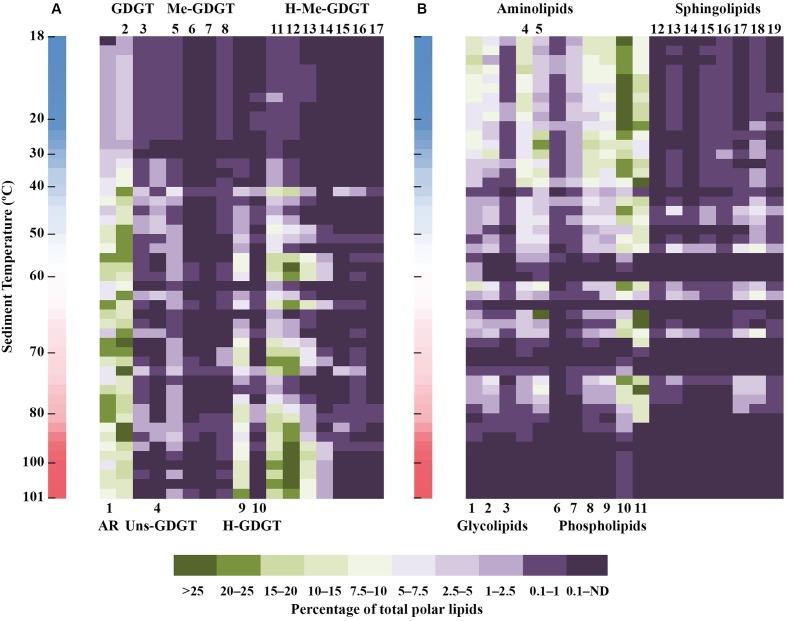
Heat map distribution of archaeal (A) and non-archaeal (B) polar lipid classes in sediments of Spathi Bay. Green to dark purple scale (in %) refers to the contribution of lipid classes relative to the total polar lipid concentration. ND, not detectable. Adjacent vertical bars indicate the thermal gradient in sediments ranging from 18 to 101°C. List of compounds in A (archaeal lipids): 1 (G-AR), 2 (G-GDGT), 3 (2G-GDGT), 4 (G-Uns-GDGT), 5 (G-Me-GDGT), 6 (G-2Me-GDGT), 7 (2G-Me-GDGT), 8 (2G-2Me-GDGT), 9 (G-H-GDGT), 10 (2G-H-GDGT), 11 (G-H-1Me-GDGT), 12 (G-H-2Me-GDGT), 13 (G-H-3Me-GDGT), 14 (G-H-4Me-GDGT), 15 (2G-H-1Me-GDGT), 16 (2G-H-2Me-GDGT), 17 (2G-H-3Me-GDGT). List of compounds in B (non-archaeal lipids): 1 (G), 2 (SQ), 3 (2G), 4 (BL), 5 (OL), 6 (PDME), 7 (PME), 8 (PE), 9 (PG), 10 (PC), 11 (CL), 12 (sPA), 13 (sP-Uk1), 14 (sP-Uk2), 15 (sP-Uk3), 16 (sP-Uk4), 17 (sPI), 18 (sPE), 19 (sPG). sP-Uk1–4: unknown glycosylated phosphatidyl sphingolipids (see Supplementary Figure S3 for structure identification).